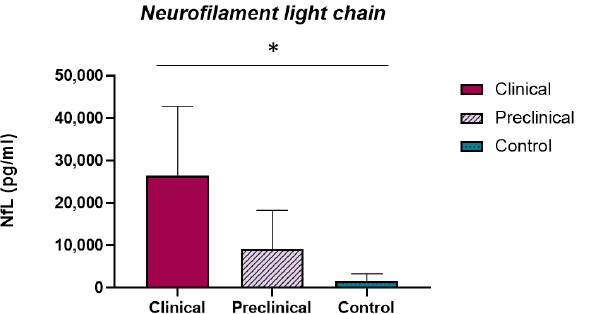
Figure 4. Analysis of CSF NfL levels in scrapie-infected and non-infected sheep. Clinical ( n = 8), preclinical ( n = 5), and control ( n = 8) groups are shown. Representations of the NfL concentrations (pg/mL) found in the CSF of the three study groups are shown. Differences between groups were studied using the one-way ANOVA test followed by the Bonferroni post hoc test. NfL concentration in CSF was significantly different between the clinical and control groups (* p < 0.05). Data are expressed as the mean ± SEM.